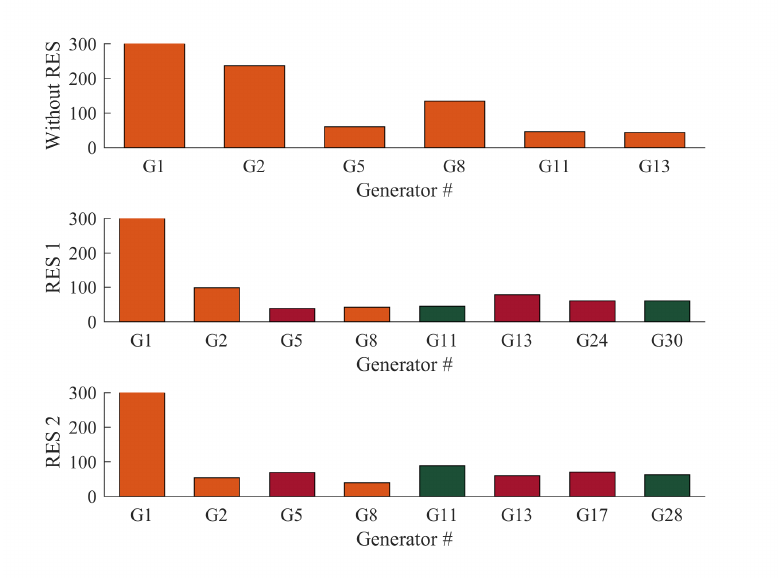
Figure 8. Fuel cost with valve point effect (USD/hr) for case 3 for IEEE 30-bus system, IEEE 30-bus Modified (1) and IEEE 30-bus Modified